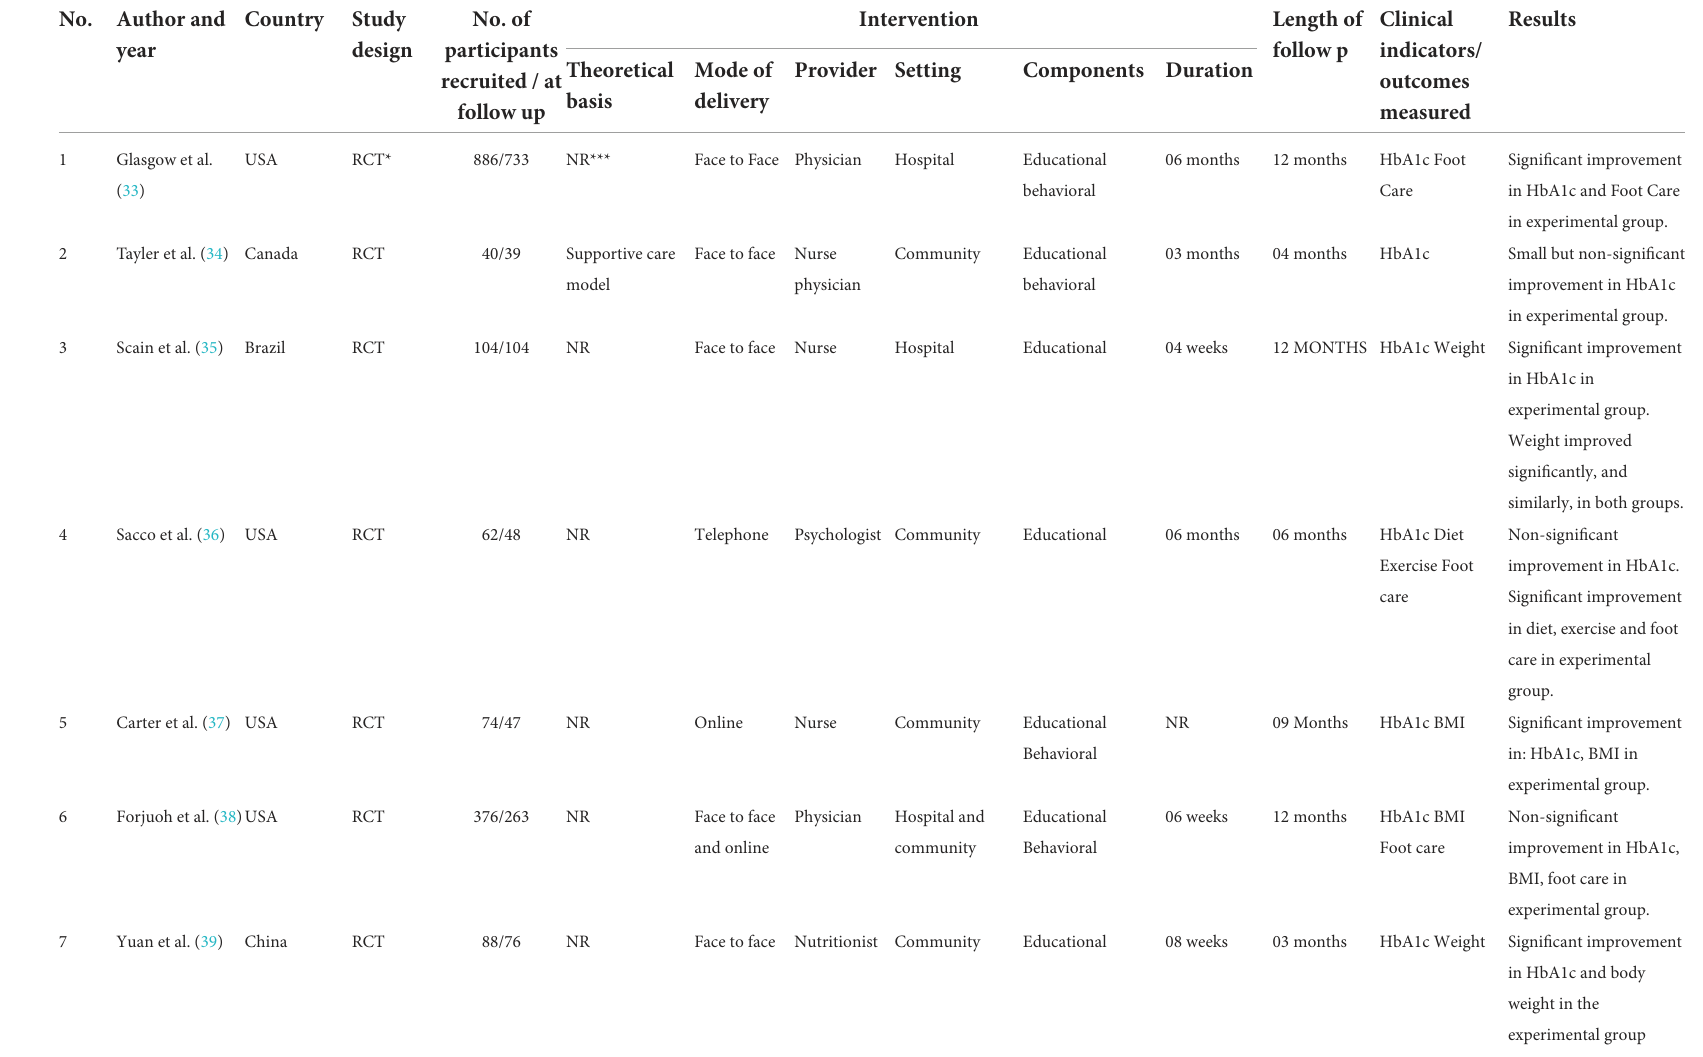
TABLE 1 Characteristics of 24 studies included in the